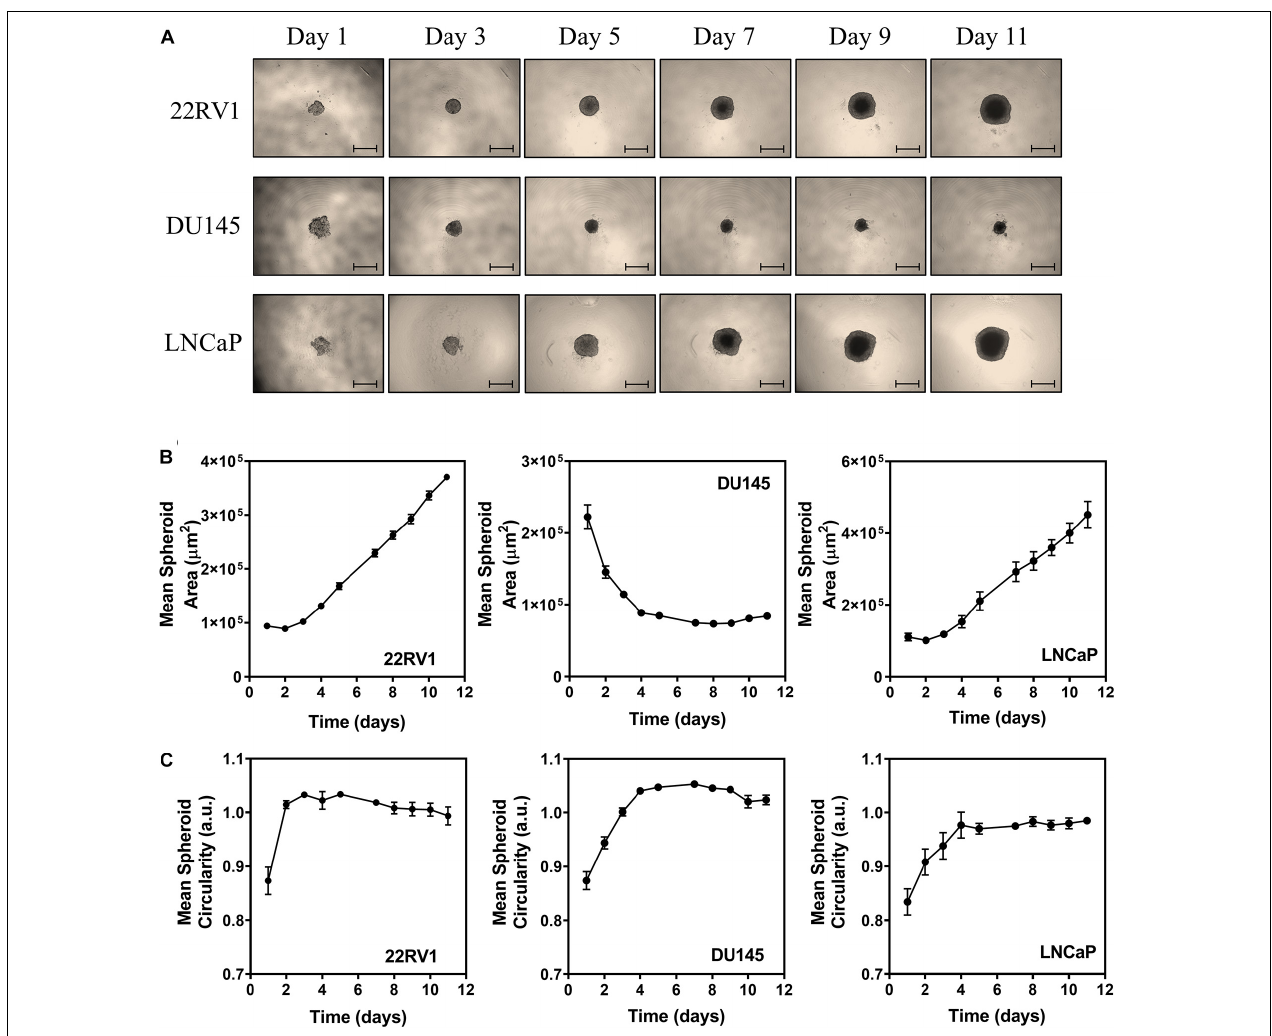
FIGURE 1 | Physical characterization of PCa spheroids. (A) Representative microscope images of 22RV1, DU145, and LNCaP spheroids. The images were acquired with a Primovert Inverted Zeiss Microscope (objective 4 × ). Scale bar, 500 µ m. (B) Growth curves represented by the mean area (in µ m 2 ) of 22RV1, DU145 and LNCaP spheroids as a function of the number of days in culture. (C) Mean circularity of 22RV1, DU145, and LNCaP spheroids represented as a function of the number of days in culture. Data are presented as the average ± S.E.M. of at least 3 independent